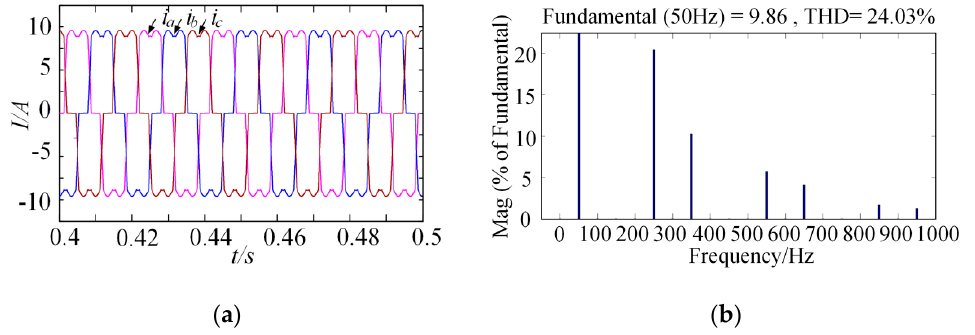
Energies 2019 , 12 , x FOR PEER REVIEW Figure 9. Before compensation: ( a ) Grid current; ( b ) Current Total Harmonic Distortion (THD).